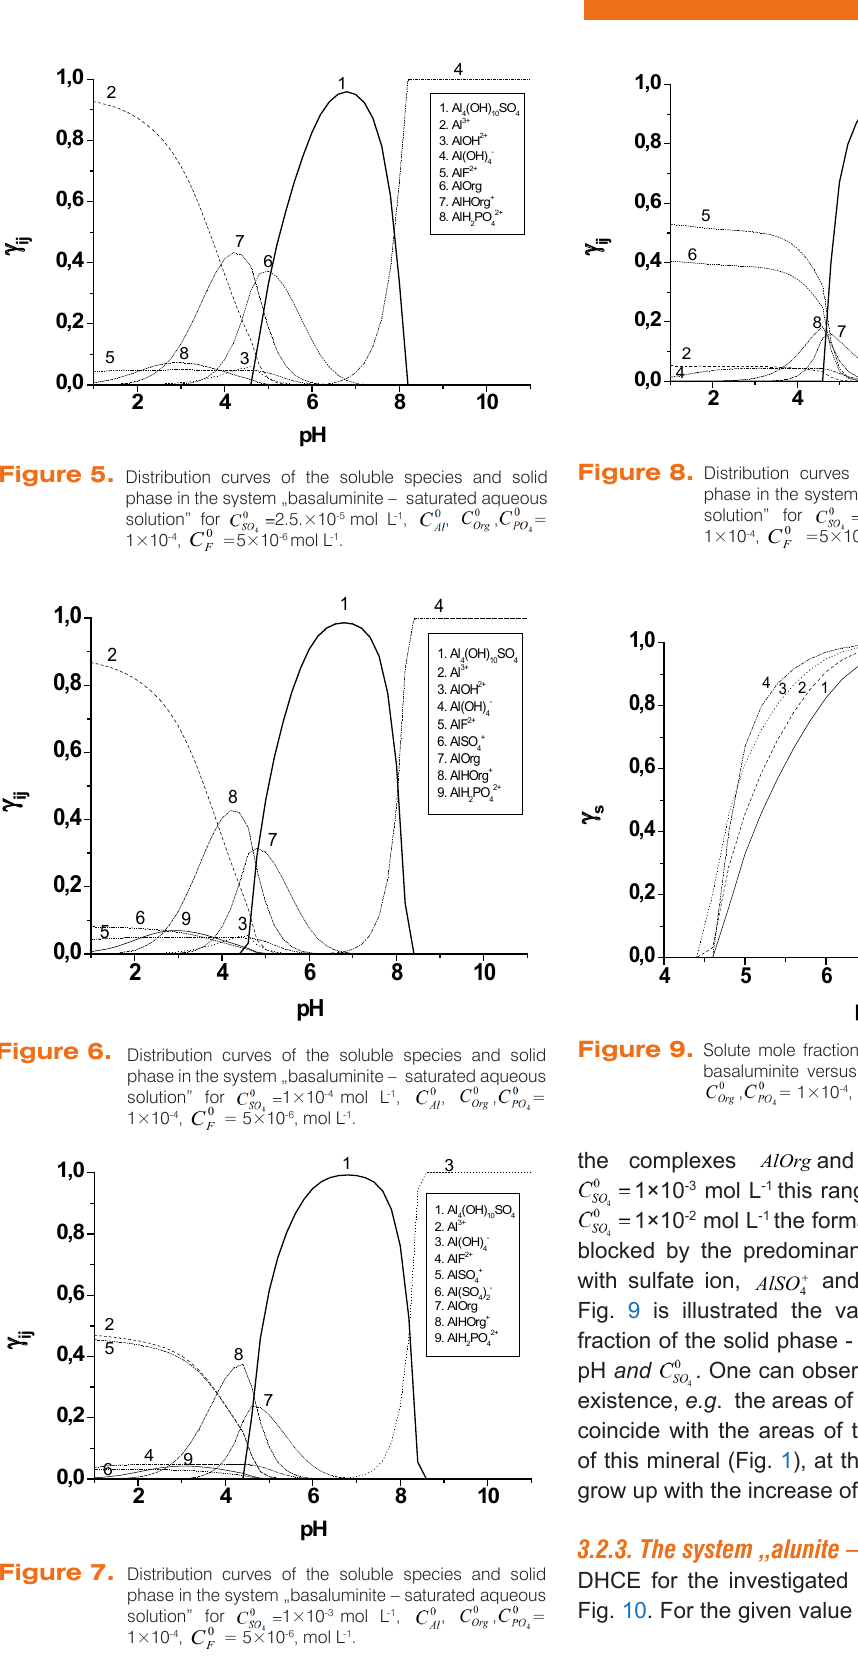
Fig. 10. For the given value of in acidic and neutral